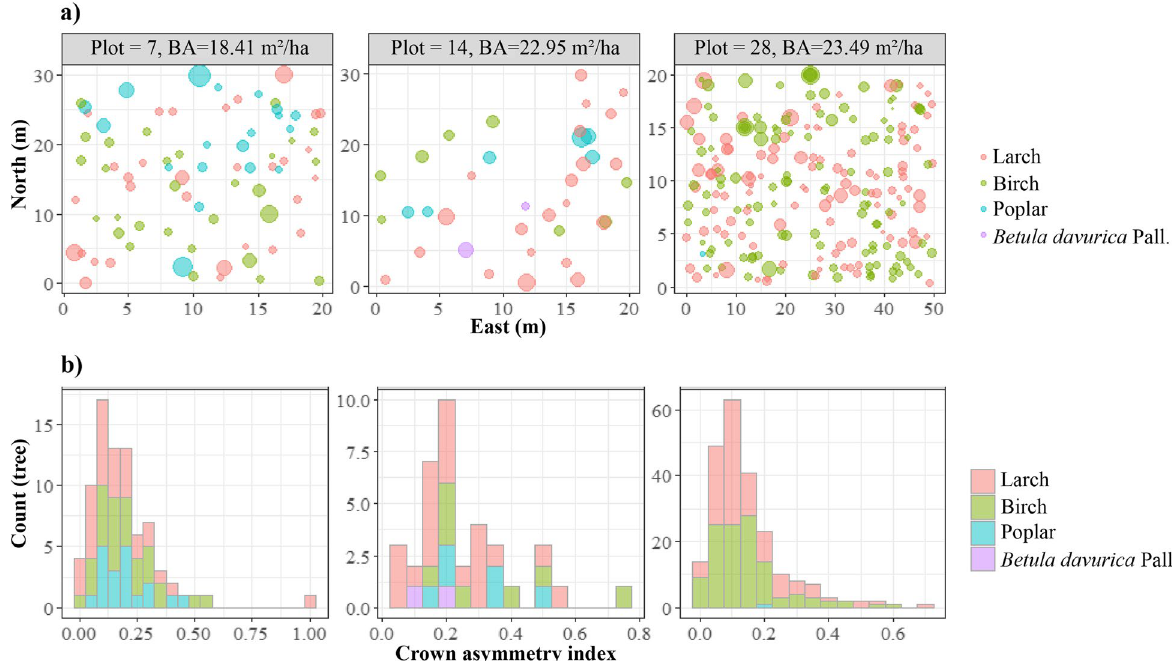
Fig. 2 a Relative positions of trees in the three plots, with the size of the circles representing CW; and b frequency distributions of crown asymmetry indices of trees in the three